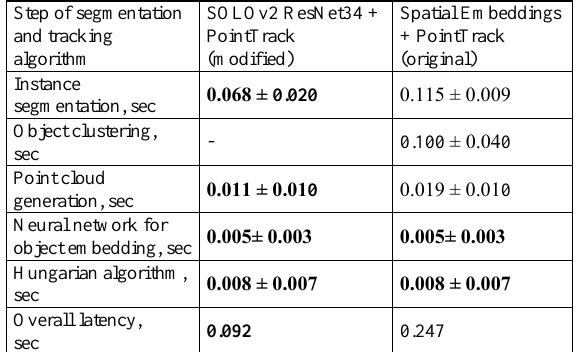
Table 2. Performance comparison between methods